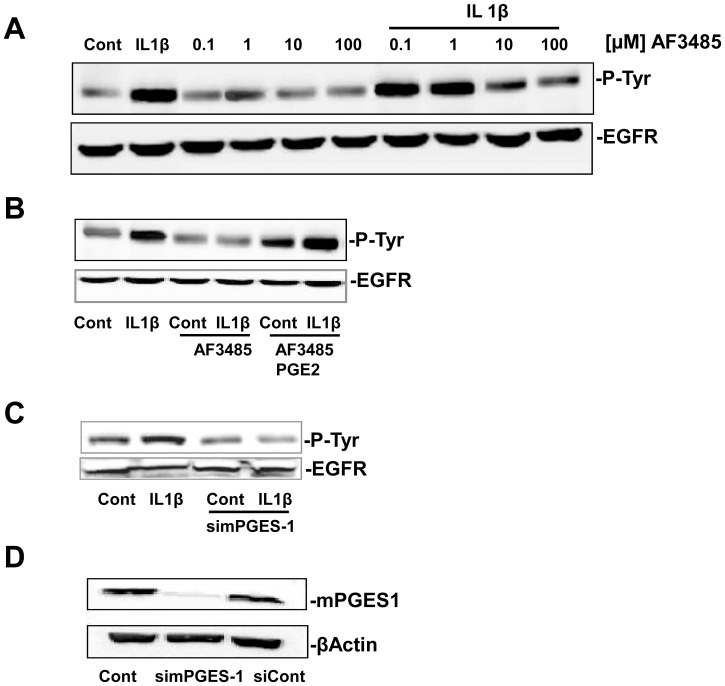
IL-1β-induced PGE2 transactivates EGFR in tumor cells.(A) EGFR phosphorylation in A431 pretreated with IL-1β (10 ng/ml, 18 h), then treated with AF3485 (0.1–100 µM, 30 min). (B) EGFR phosphorylation in A431 in the conditions described in panel A, in presence/absence of PGE2 (1 µM). (C) EGFR phosphorylation in A431 silenced for mPGES-1, then treated with IL-1β (10 ng/ml, 18 h). (D) mPGES-1 expression in A431 silenced with siRNA for mPGES-1 or control siRNA. Gels (Western blot) are representative of three experiments with similar results.